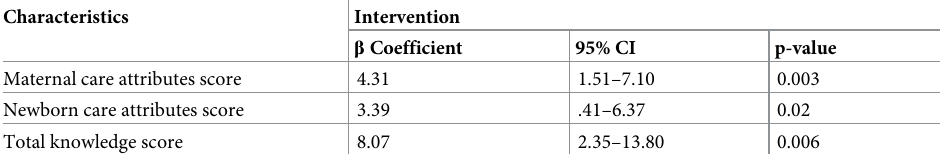
Table 9. Effect of social media-based education on PNC knowledge score of pregnant women attending ANC check-up at DH hospital in the intervention group, n =